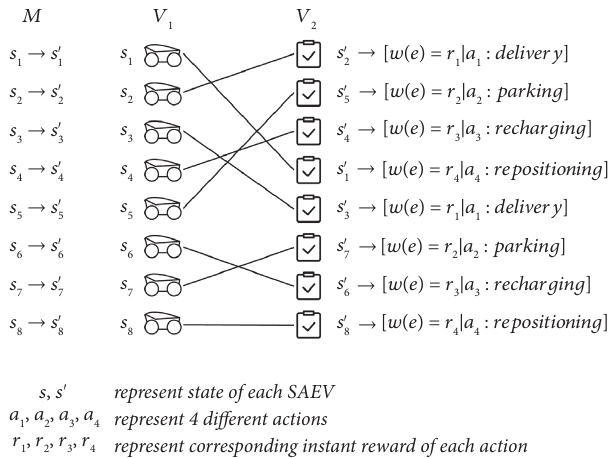
Figure 2: Bipartite graph of task allocation instructions for